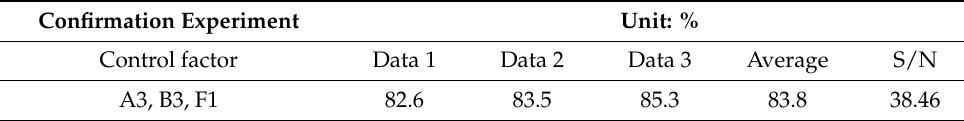
Table 18. The confirmation experiment far-infrared emissivity.